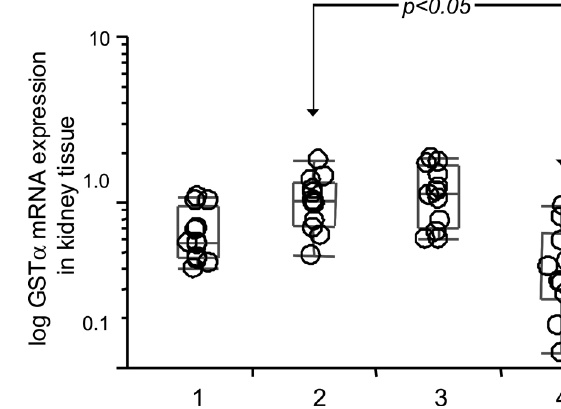
Figure 1 - Box diagram comparing relative GST- α 3 mRNA expression levels in pancreas tissues in Groups 1, 2, 3 and 4. The horizontal line within the box plot represents the median value, the box plot limits refer to 25th to 75th percentiles, and the box plot bars include the 10th to 90th percentiles for mRNA levels.